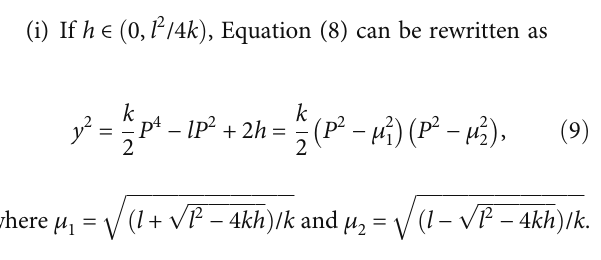
= 2, a = 1, a = 1/2, k 2 3 4